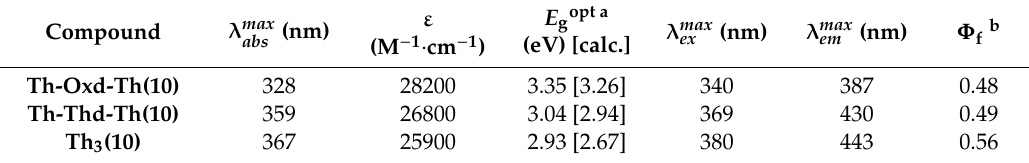
Table 2. Summary of the optical properties of the compounds studied.